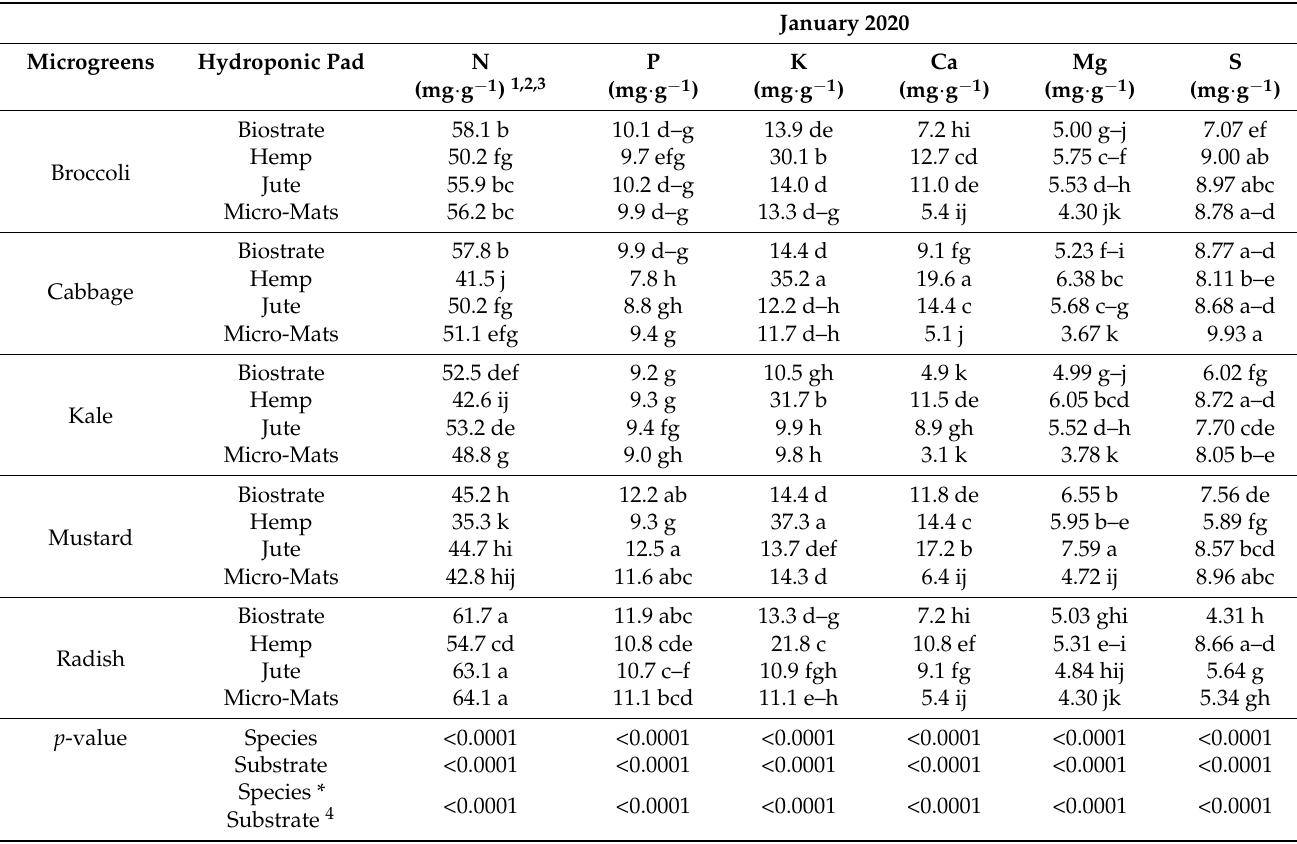
Table 7. Macronutrient concentrations in five microgreens affected by the interaction between species and hydroponic